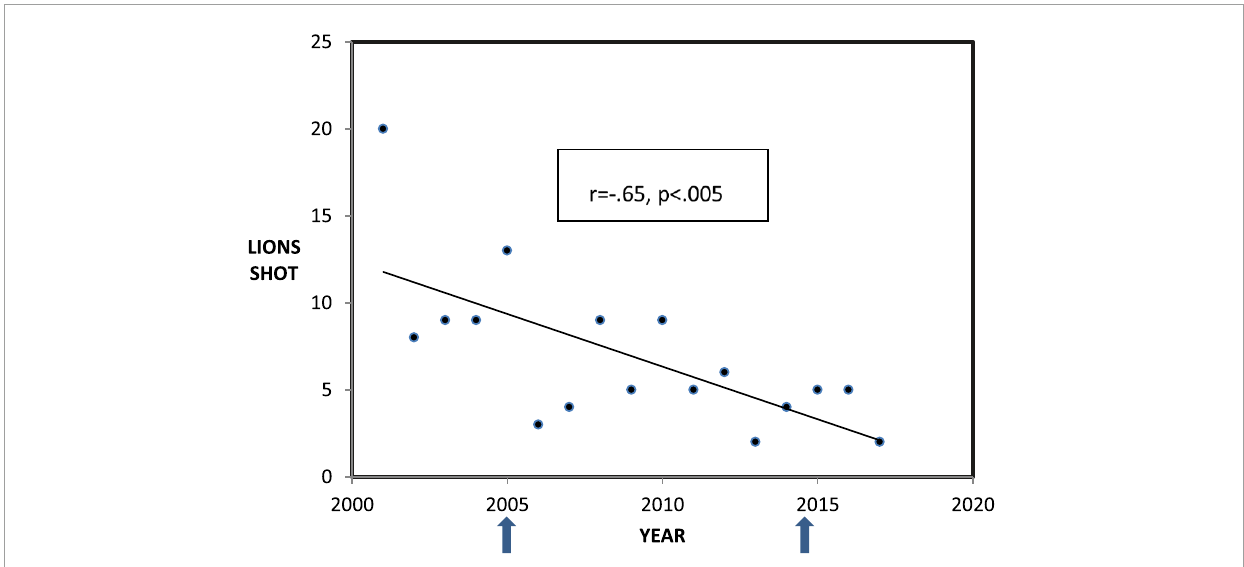
FIGURE8 Decline in retaliatory lion shooting on commercial ranches of Laikipia between 2001 and 2017. Arrows indicate the introduction of steel and chain link mobile bomas in 2005 and the GPS Early Warning System in 2014.